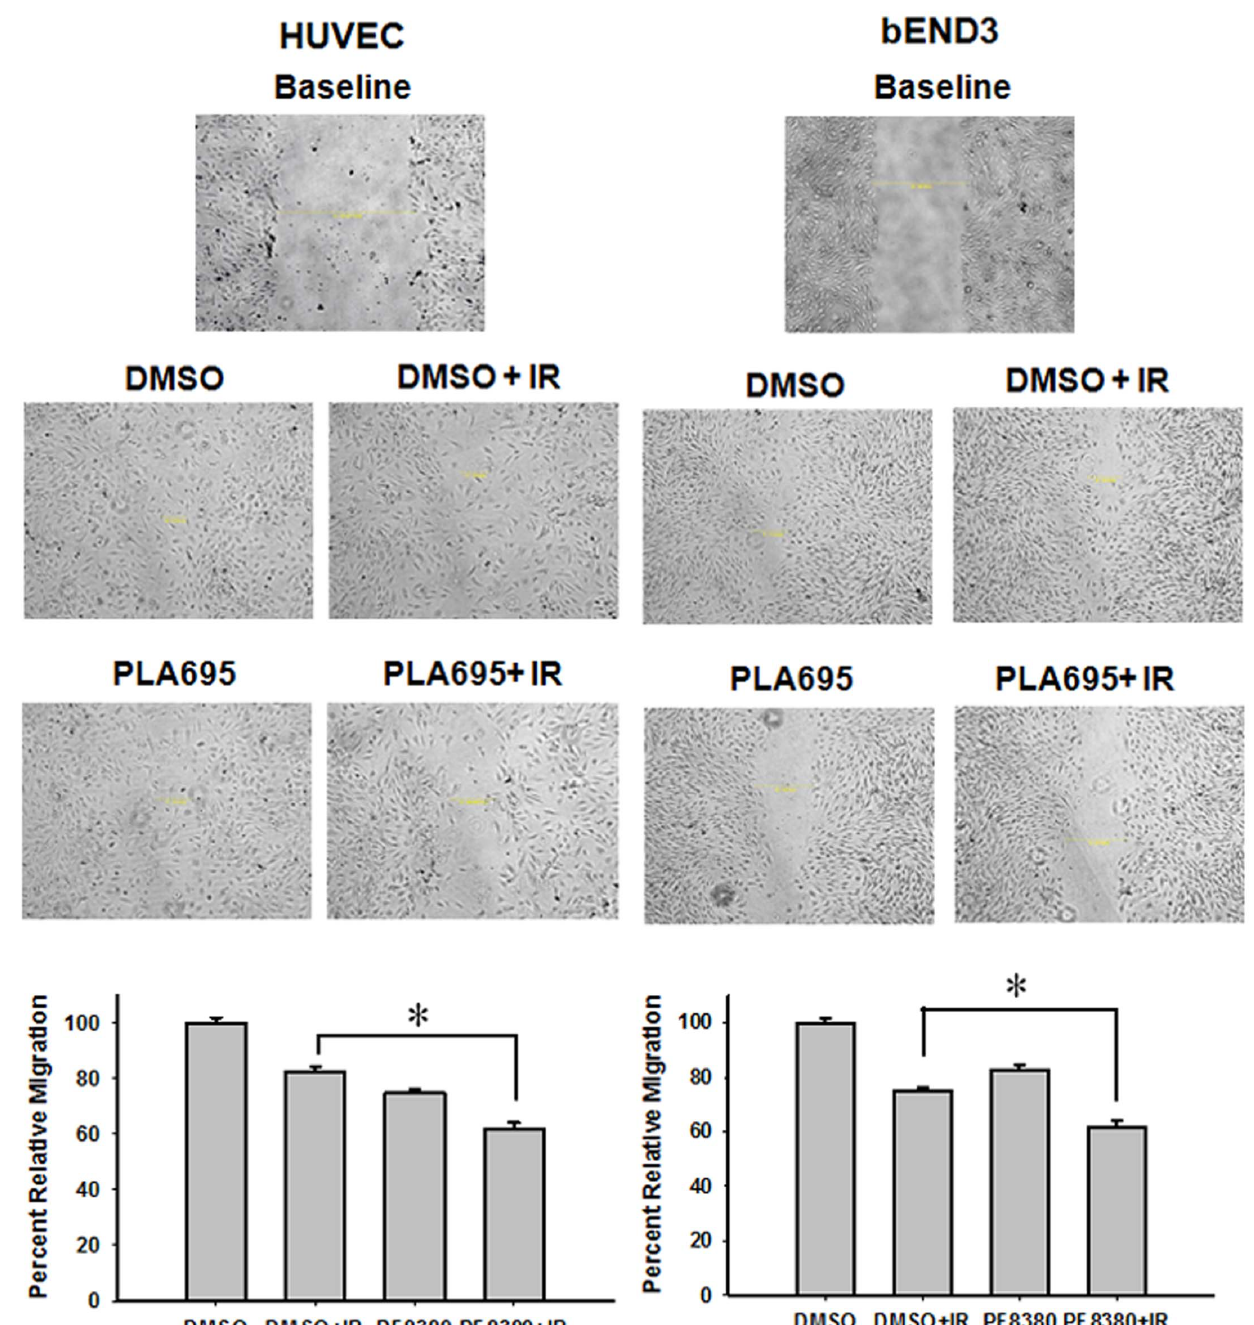
Figure 5. PLA-695 reduces endothelial cell migration after radiation. HUVEC and bEND3 cells were plated on 60 mm plates and allowed to grow to 80% confluency. The semi-confluent cell layer was scraped using a 200 m l sterile pipette tip to create a scratch/wound devoid of cells. The remaining cells were treated with vehicle control or 300 nM PLA-695 for 45 min prior to IR with 3 Gy. Migration was assessed at 24 h after treatment. The number of cells migrated in the scratch/wound were counted and normalized to surrounding cell density per HPF. Shown are representative photomicrographs and bar graphs representing the mean percentages of migrating cells relative to corresponding controls with SEM from three experiments.